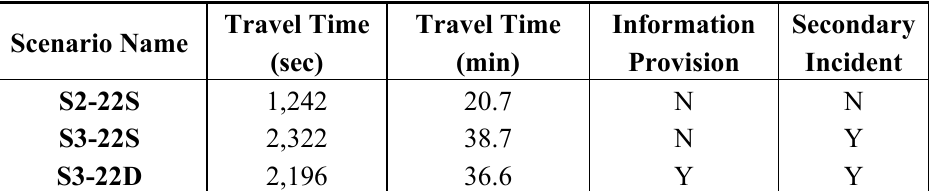
Table 11. EMS Vehicle Travel Times to the